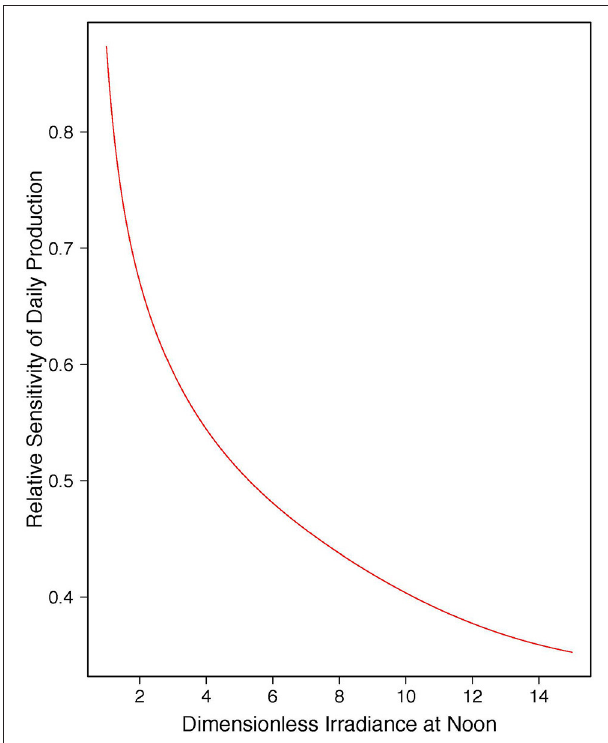
FIGURE 1 | Relative sensitivity of daily, watercolumn primary production ( P Z , T ) to changes in dimensionless irradiance at noon ( I m Equation (18).